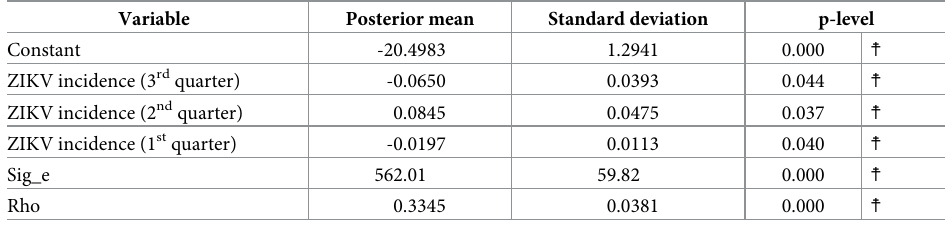
Table 1. Results of SAR Tobit—Dependent variable: Microcephaly incidence (4 th quarter), Brazil—2016. Variable